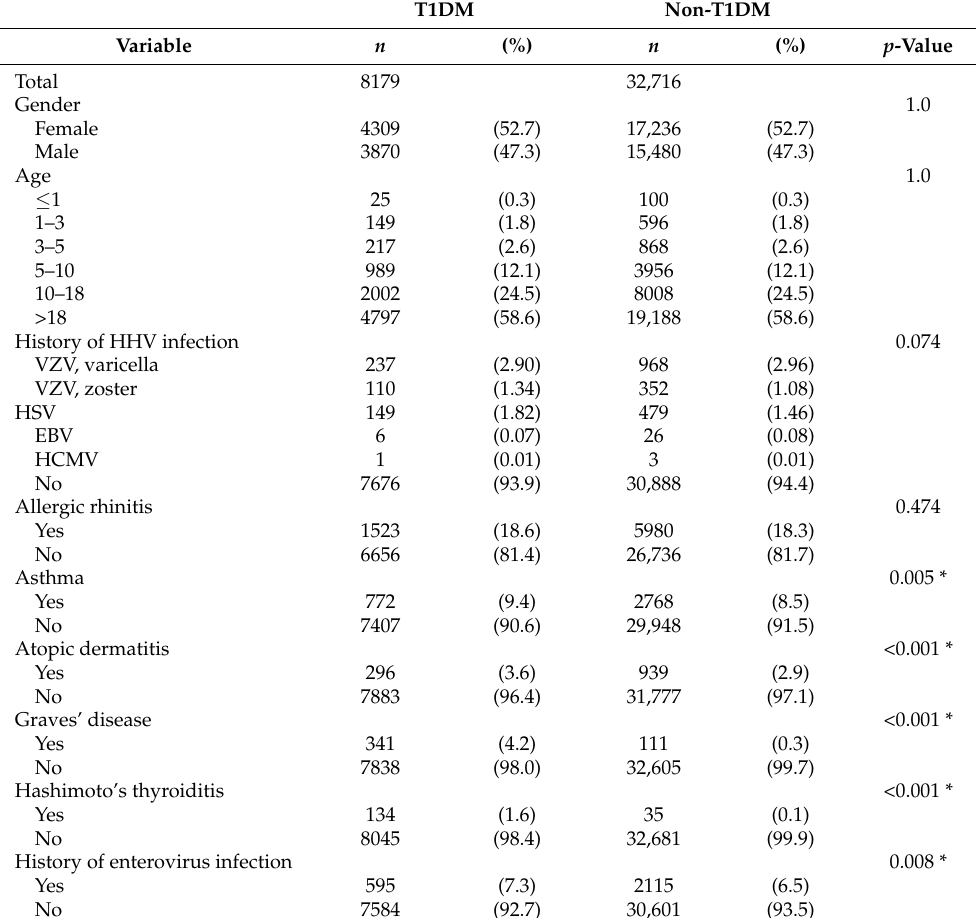
Table 1. Distribution of selected characteristics of 8179 cases and 32,716 controls.